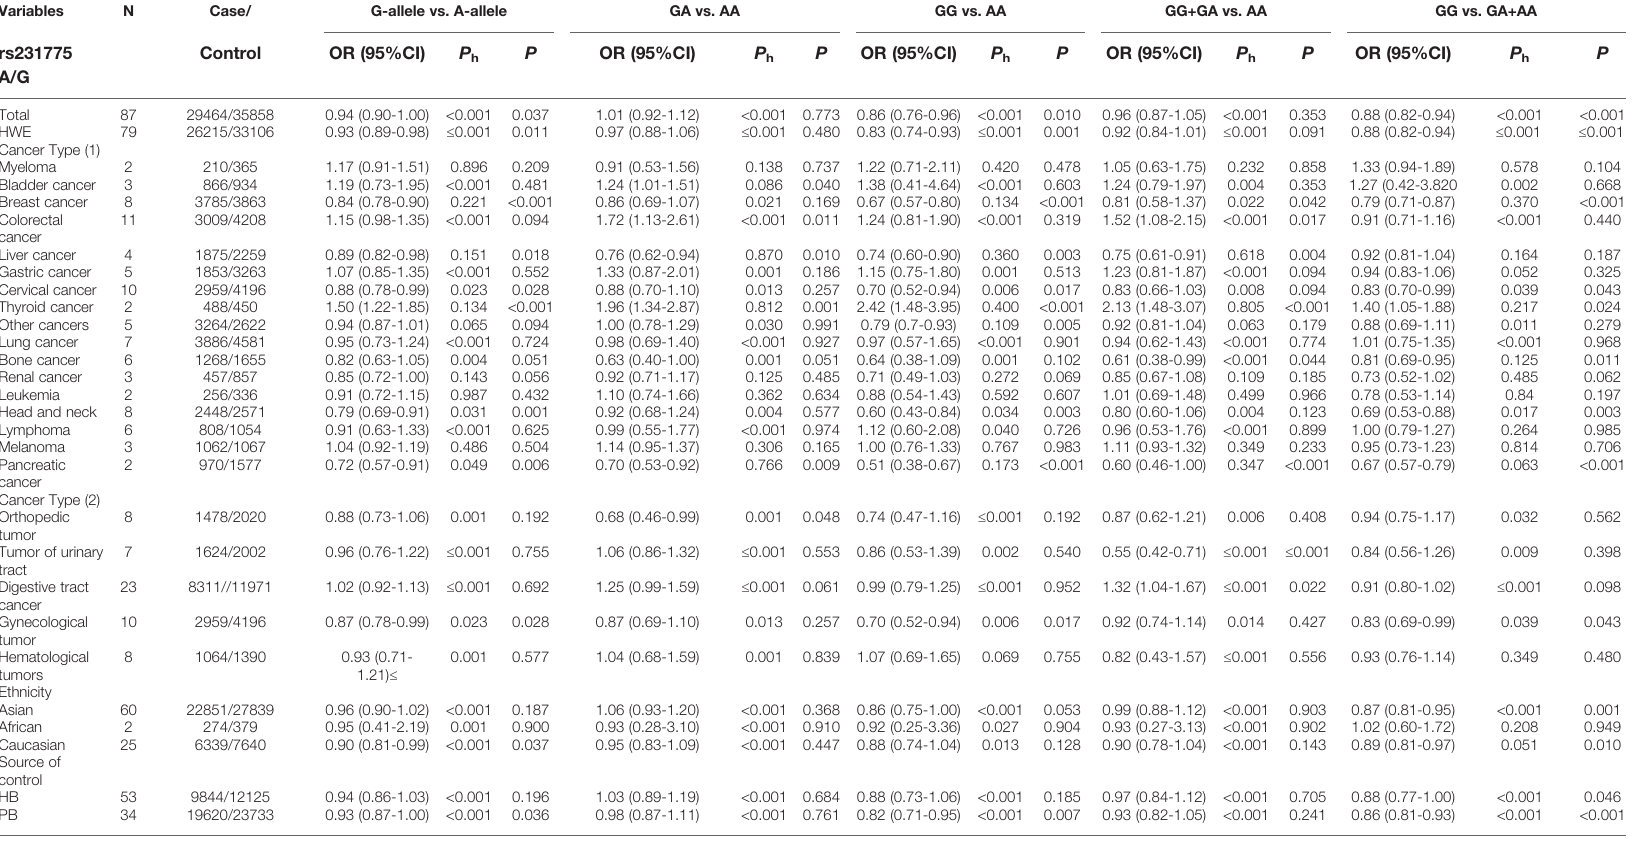
TABLE 2 | Strati fi ed analysis of CTLA-4rs231775 A/G variation on cancer susceptibility.